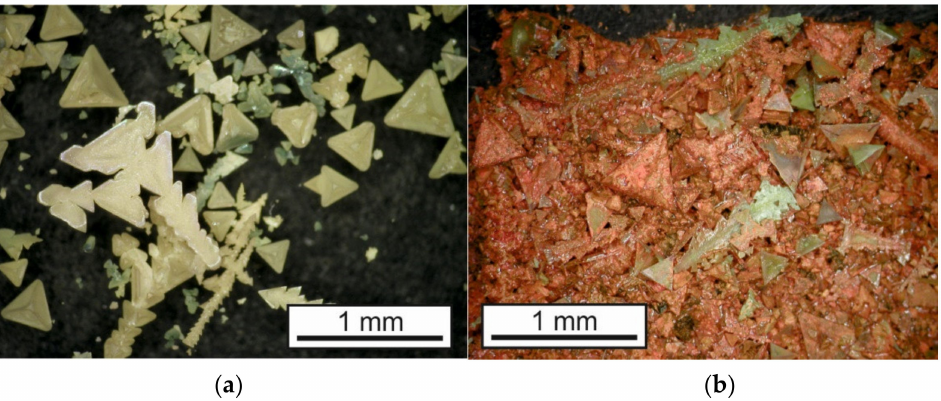
Figure 13. Failed extraction of CuCl crystals from gel: ( a ) Undamaged product, extracted mechani- cally; ( b ) Cu-coated and partly dissolved crystals after thermal treatment of the gel with addition of